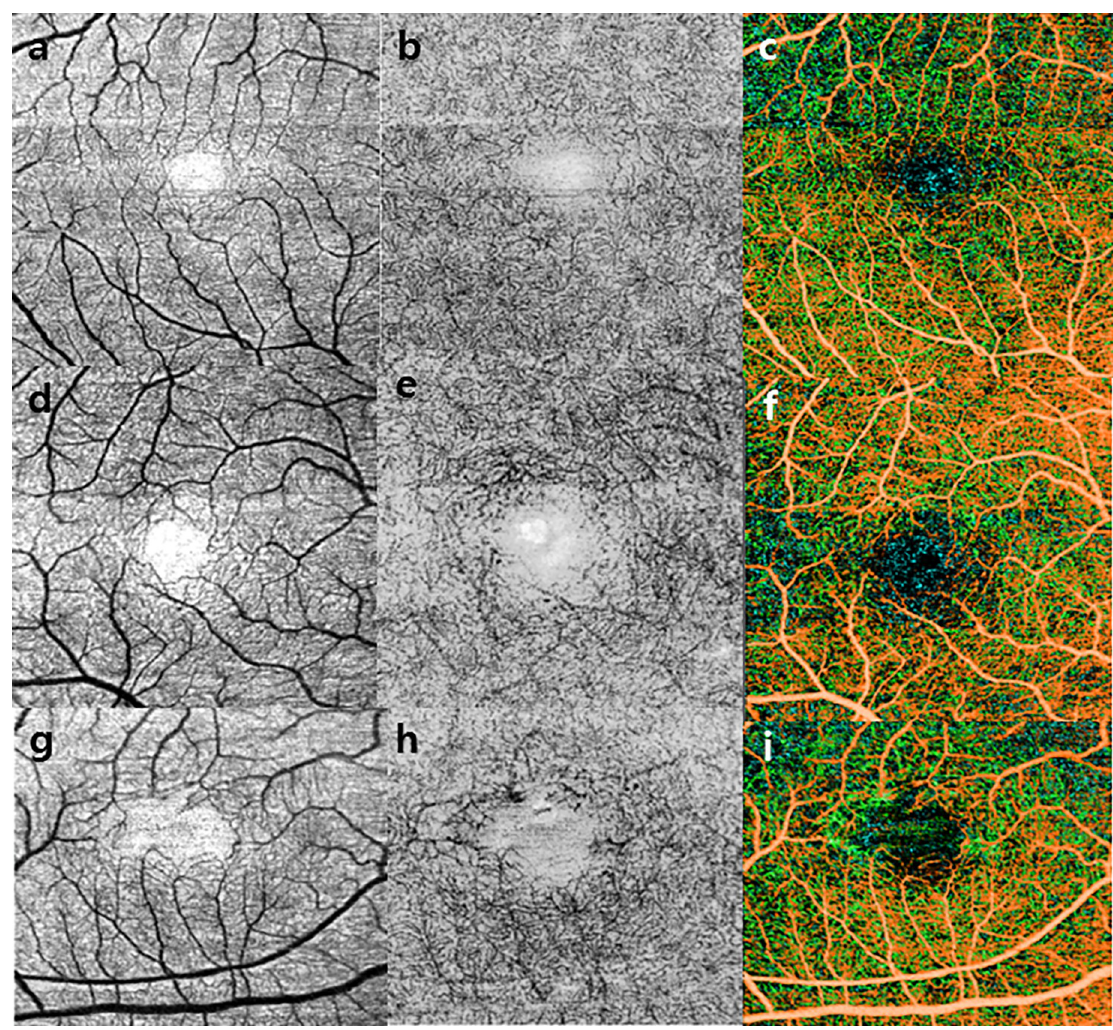
Fig 3. Changes in the foveal avascular zone (FAZ) between MacTel 2 and control eyes as seen on optical coherence tomography angiography. (a) Superficial capillary plexus; (b) deep capillary plexus; and (c) color stack images of normal eyes; (d–f) the same images of an eye with early stage MacTel 2 and (g–i) an eye with advanced MacTel